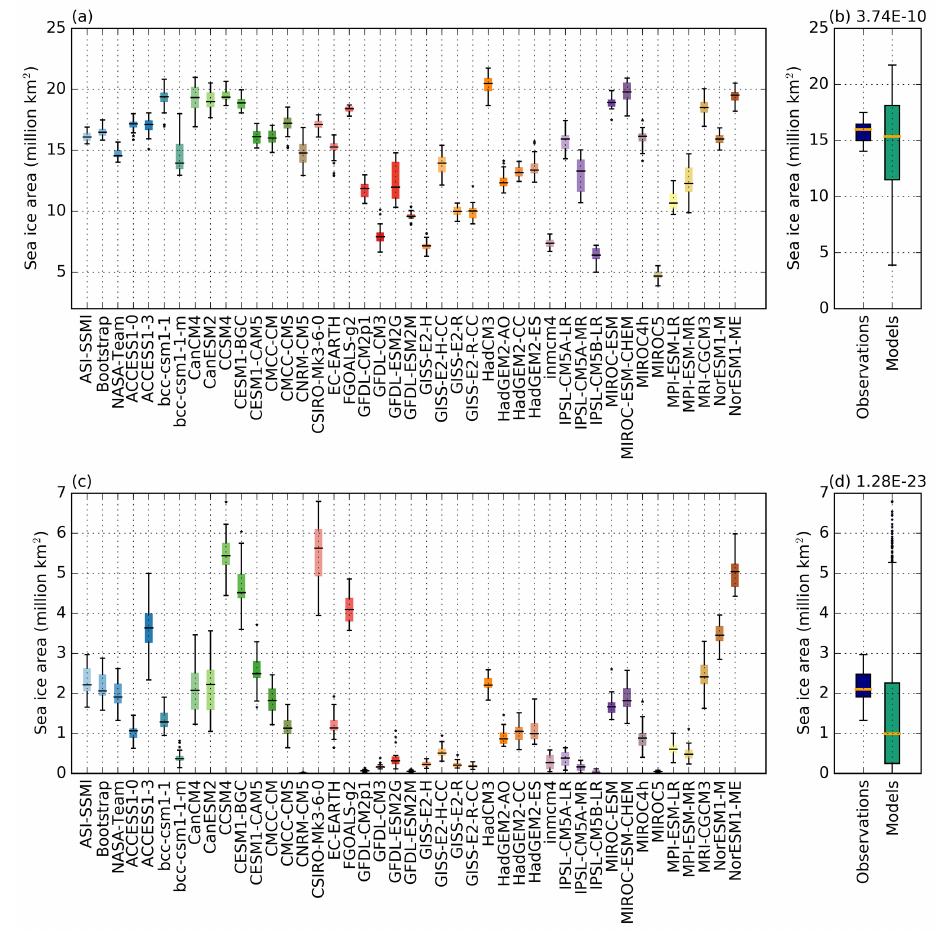
Figure 1. Sea ice area for the months where the maximum (a, b) and minimum (c, d) of the seasonal cycle occur. Populations include data from all years from 1992 to 2014 with box plots for (a, c) the three observational products (ASI-SSMI, Bootstrap, and NASA Team) and all CMIP5 models listed in Table 1 individually, and (b, d) for the ensemble of observational products and the CMIP5 model ensemble. Boxes extend from the lower to upper quartile values of the data with a line at the median. Whiskers show 1.5 times the interquartile range; beyond this data are considered outliers and plotted as individual points. The text labels in (b, d) is the p value calculated from a Kolmogorov– Smirnov test, which represents the confidence that the two populations come from the same